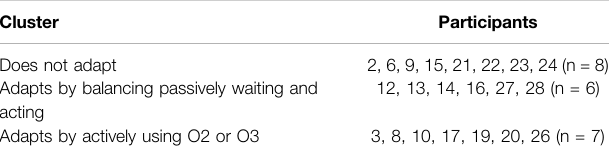
TABLE 4 | The clusters resulting from manually clustering participants based on whether they adapted to the robot across the whole experiment. Cluster Participants